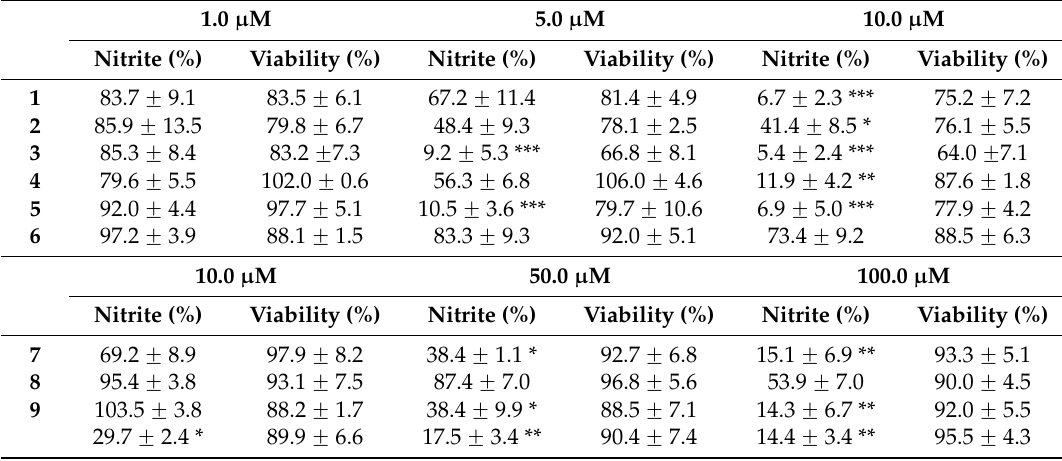
Table 2. NO inhibitory effects of compounds 1 – 9 isolated from T. papyriferus on LPS-activated BV2 microglia cells.